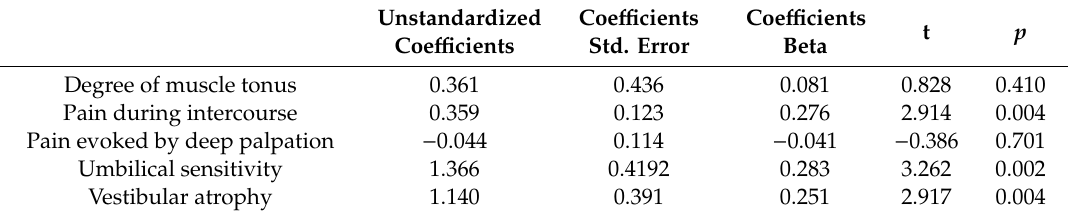
Table 3. Regression model to define predictors for pain variability in the anterior vestibule.